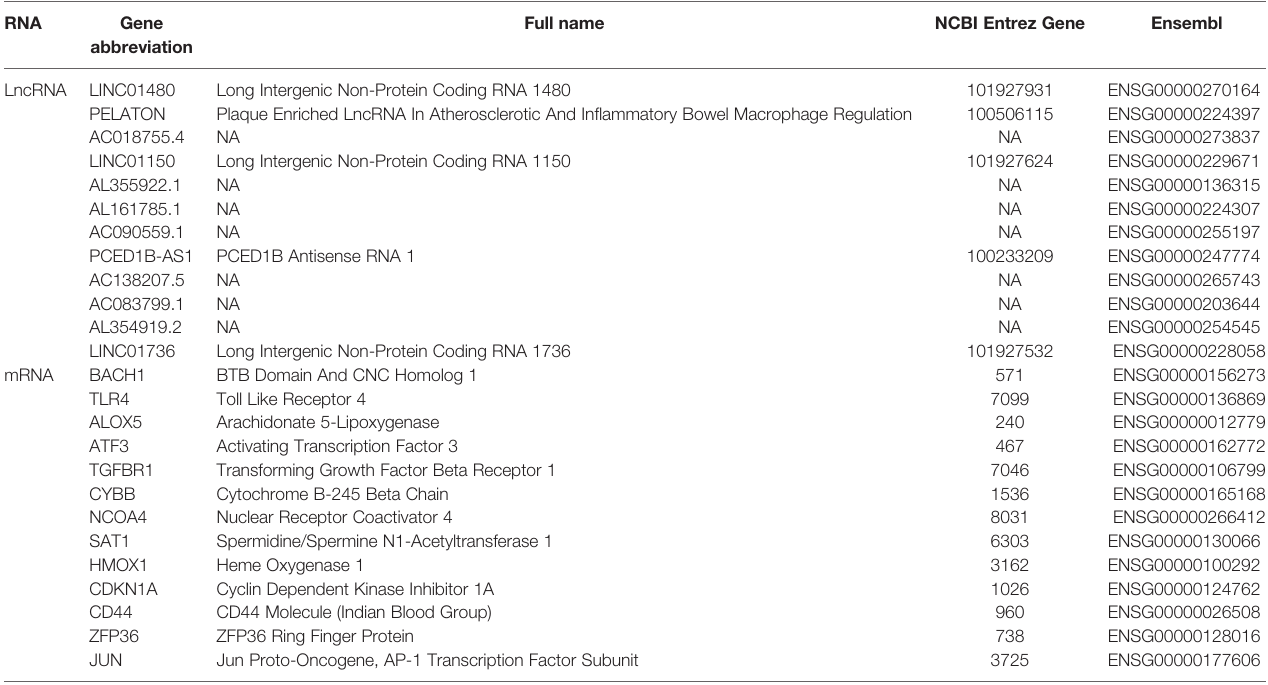
TABLE 1 | Screening of 12 LncRNAs and 13 mRNAs associated with Ferroptosis.